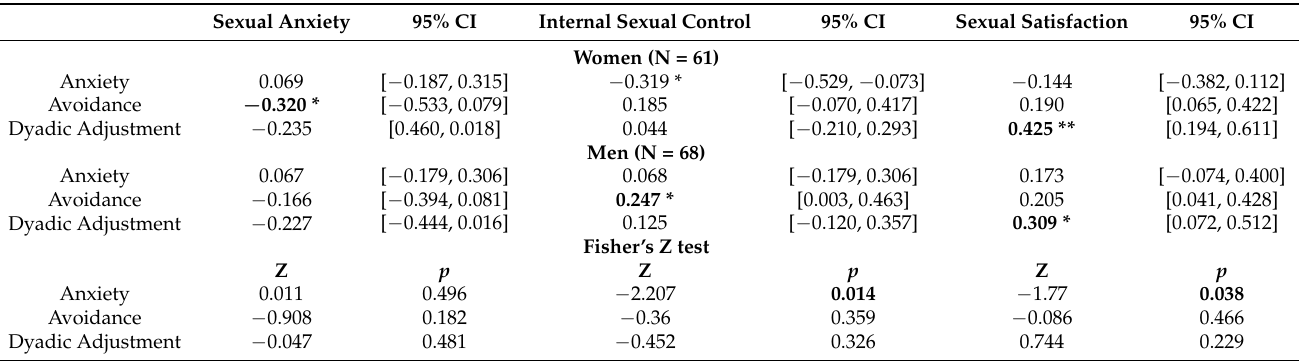
Table 3. Correlations and Fisher Z Test Coefficients for sexual dimensions, attachment, and dyadic adjustment in infertile women and men.